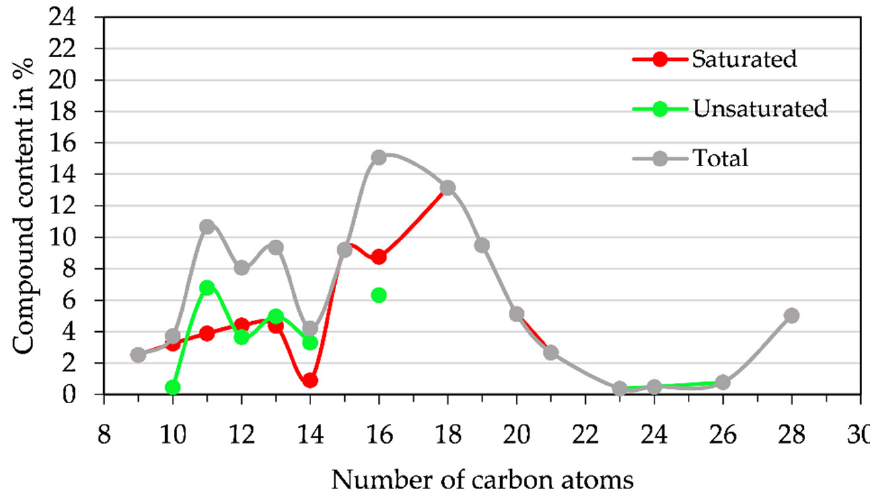
Figure 9. Percentage of compounds in (HDPE + 1% 2 ‐ EHN) pyrolysis oil and their carbon number (total compound content—grey, saturated compound content—red, unsaturated compound con ‐ tent—green).